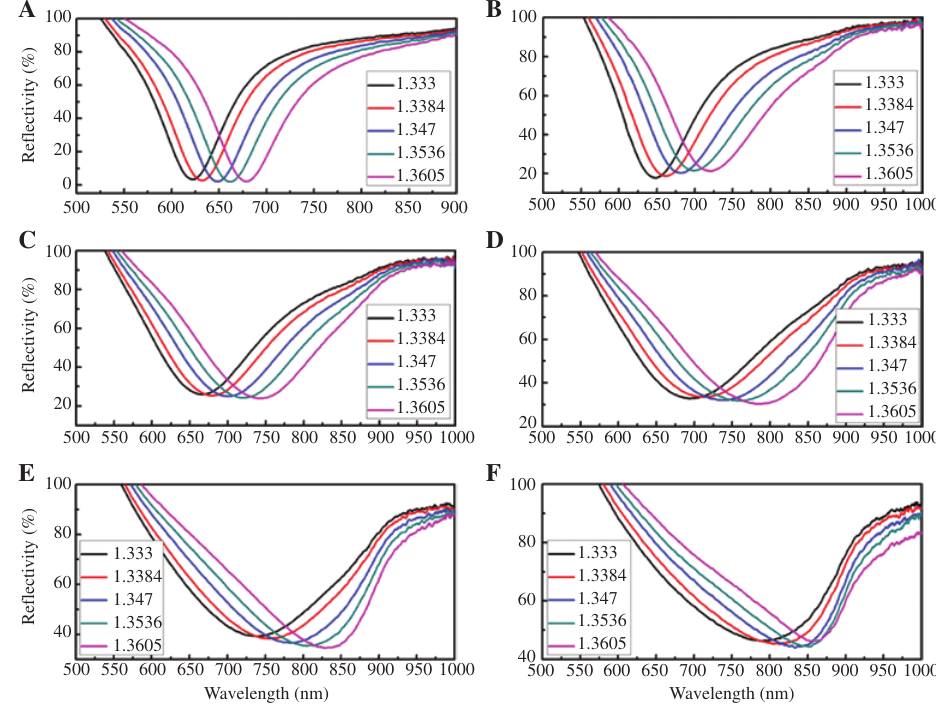
Figure 5: The reflection spectrum of SPR sensor with different thickness GeSe nanosheets. (A) without spin coating; (B) one; (C) two; (D) three; (E) four; (F) five times spin coating as the refractive index of sensing medium changing from 1.333 to 1.3605.